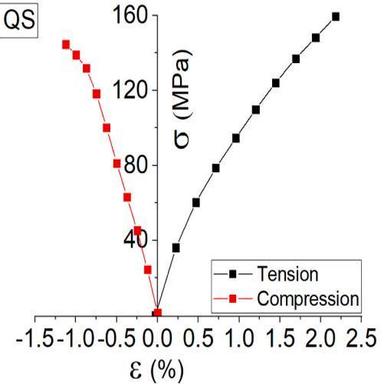
Tension and compression stress-strain curves for RO-A-